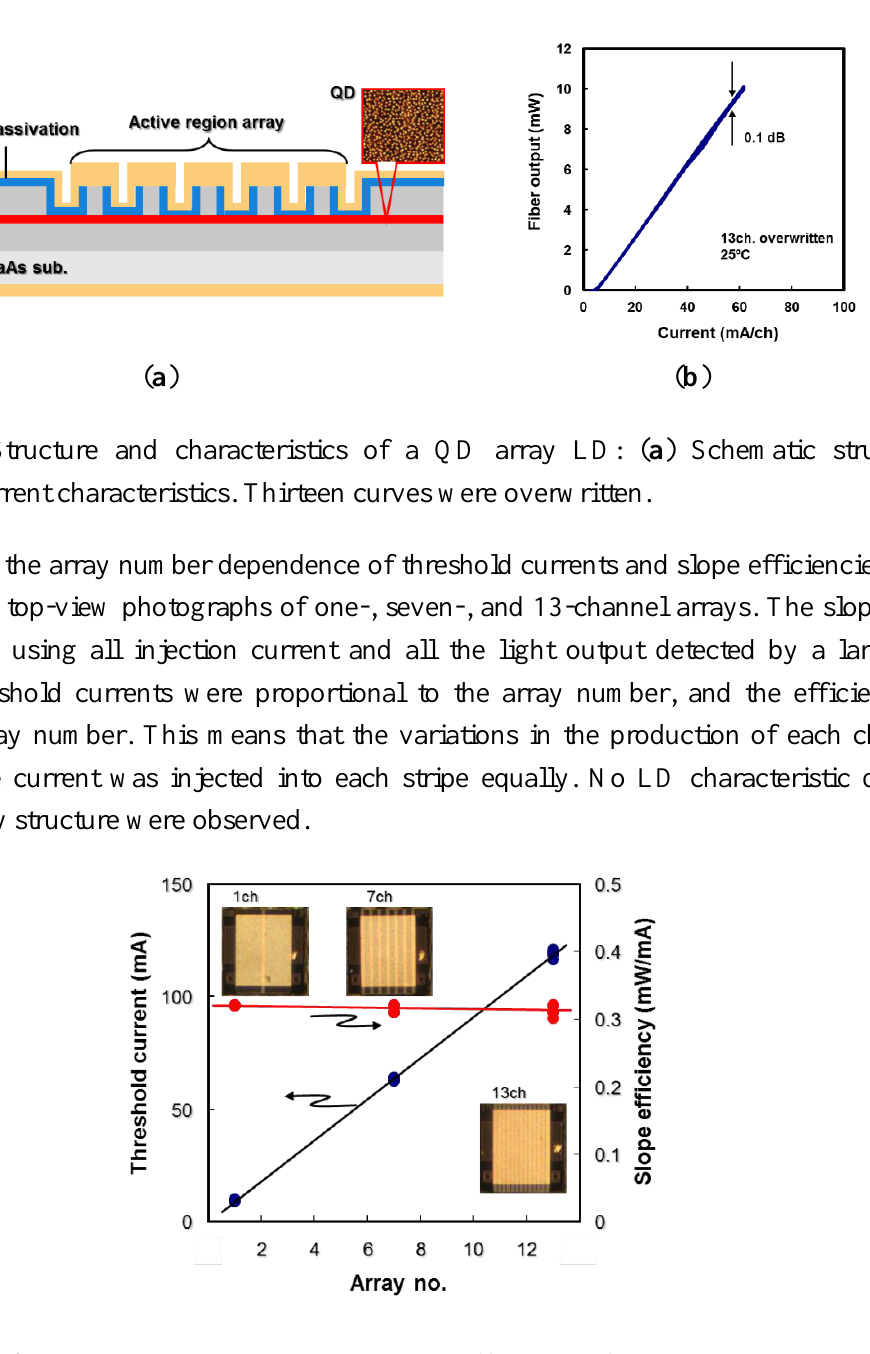
Figure 2. Threshold current and slope efficiency of QD array